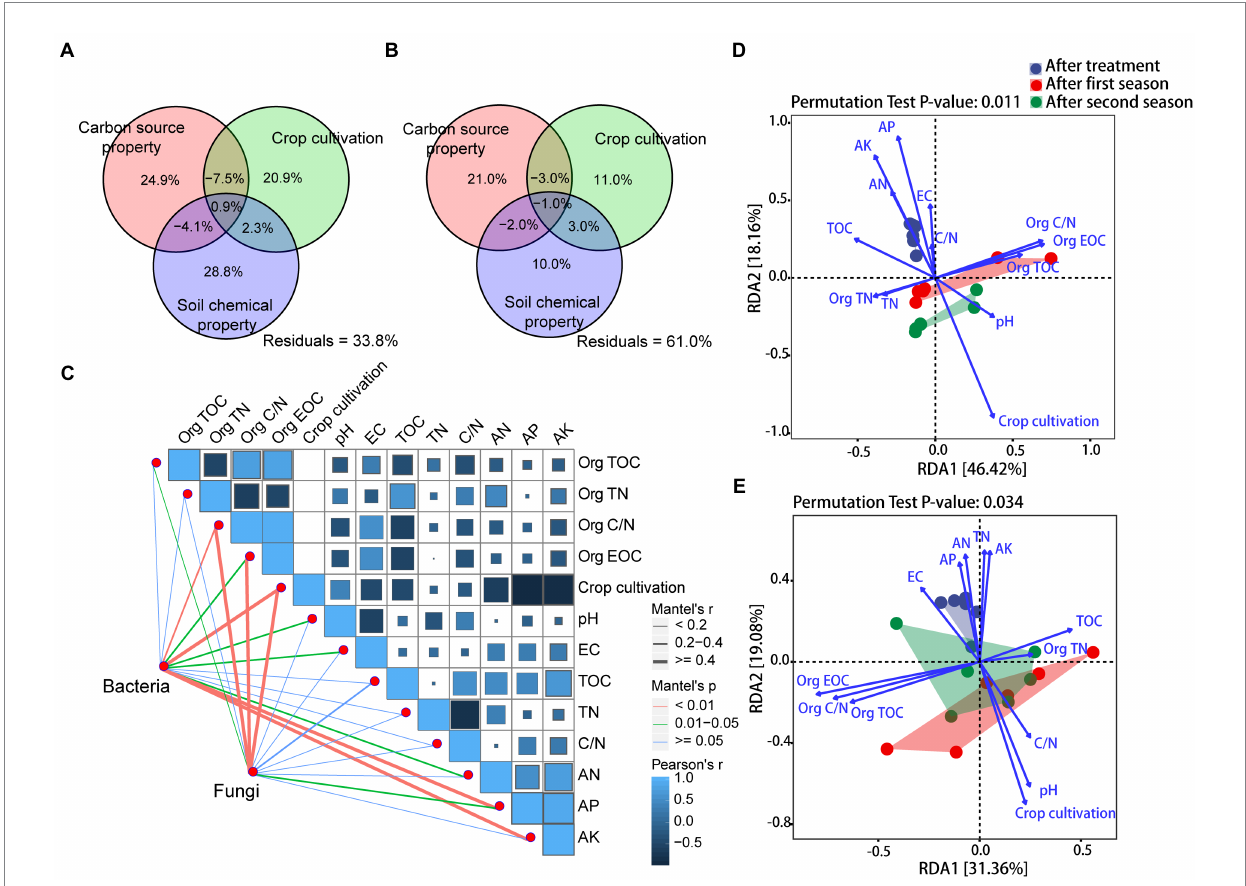
FIGURE 3 (A,B) Variance partitioning analysis (VPA) of the effects of carbon source property, crop cultivation, soil chemical property, and their interactions on soil bacterial and fungal communities, (C) Pearson’s correlation coefficients of bacterial and fungal ASVs and impact factors based on Mantel tests, and (D,E) Redundancy analysis (RDA) of bacterial and fungal ASVs and impact factors. Impact factor abbreviations are defined in Table 1 and Figure